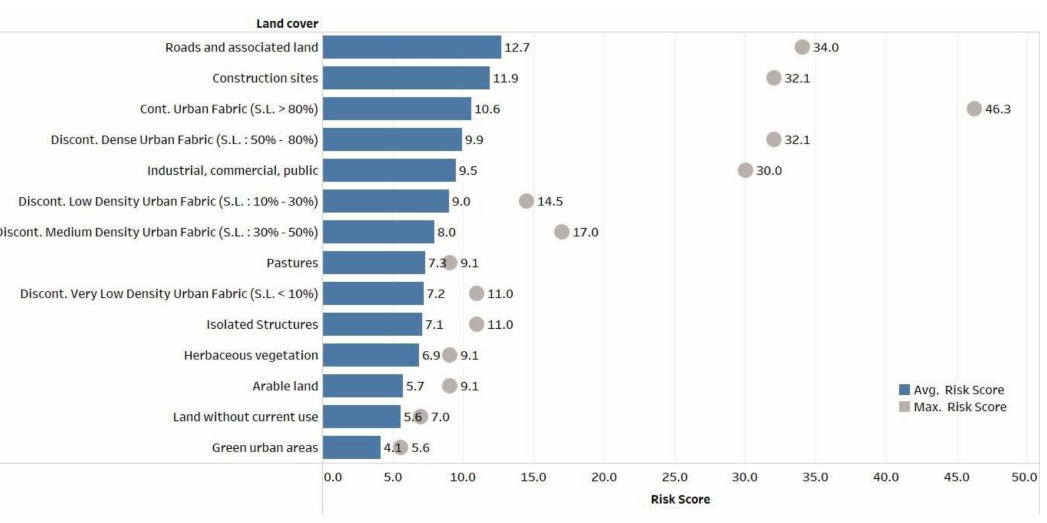
Figure 6. The mean and the maximum pluvial flood risk scores according to different land cover